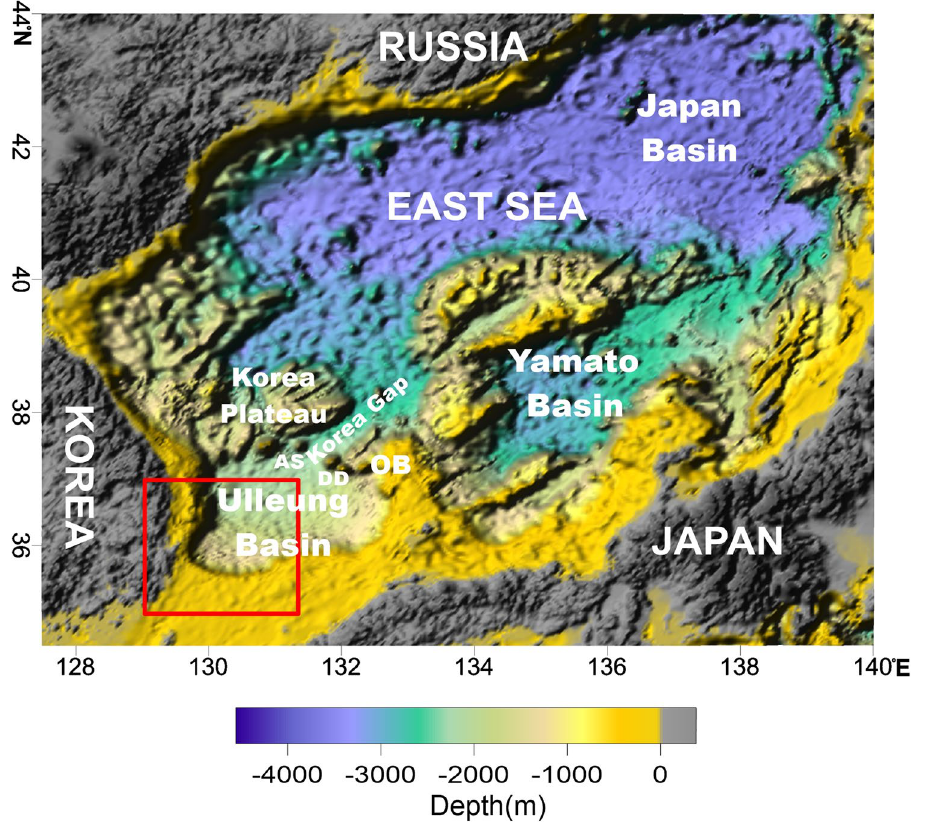
Figure 1. Bathymetry of the East Sea (Sea of Japan). The East Sea is surrounded by Korea, Japan, and Russia, and includes three deep basins. The red box represents the study area. AS – Anyongbok seamount; DD – Dokdo (Dok Island); OB – Oki bank. This figure was generated using the Surfer software (https:// www. golde nsoft ware.